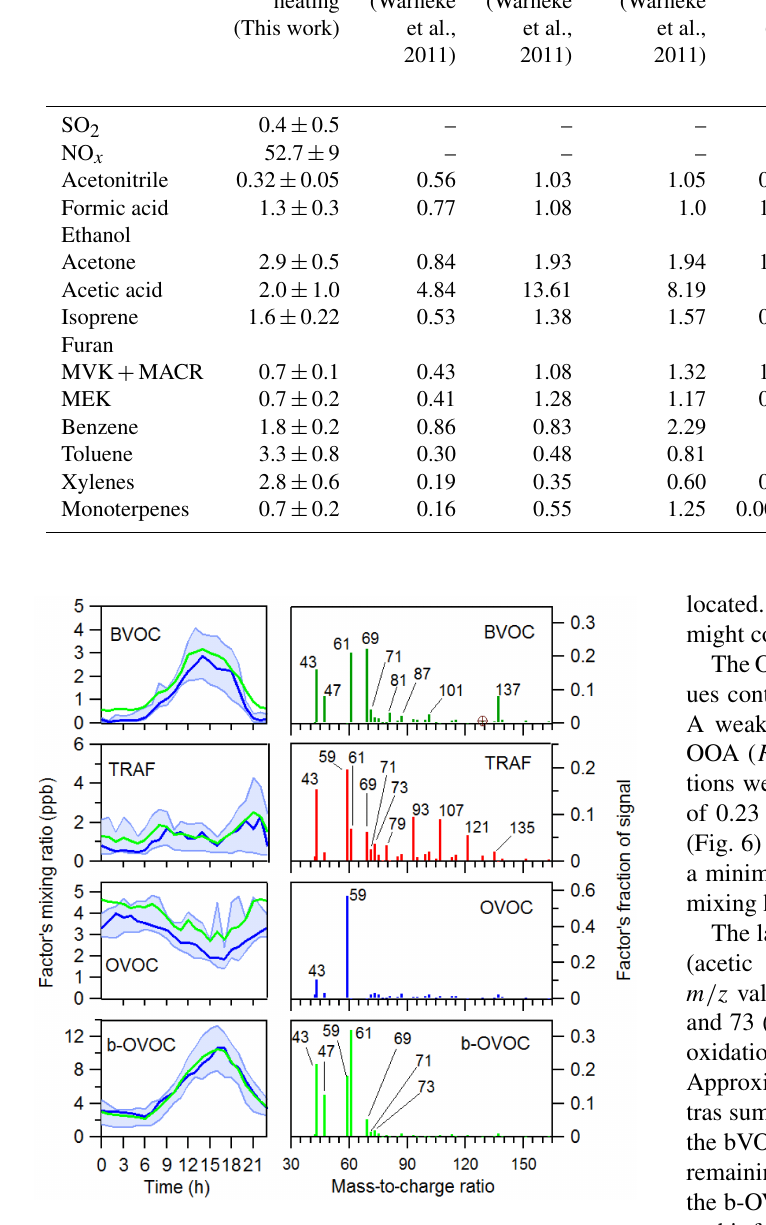
Figure 6. Results of Patras summer campaign PMF analysis. The left side shows the diurnal profiles of the factors. Green lines present the average values. The median value is shown with blue. The blue area is the interquartile range. The right side presents the m/z com- position of each factor as a fraction of signal for each m/z